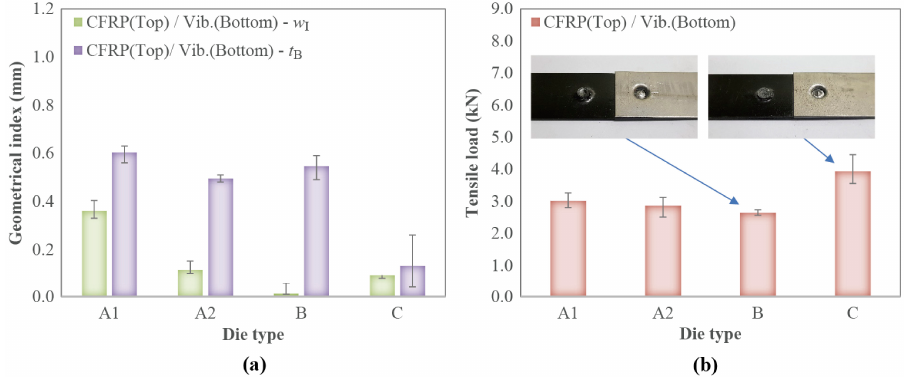
Figure 11. ( a ) w I and t B and ( b ) tensile shear loads for self-piercing riveted joints between CFRP and vibration-damping steel panels under di ff erent die types.